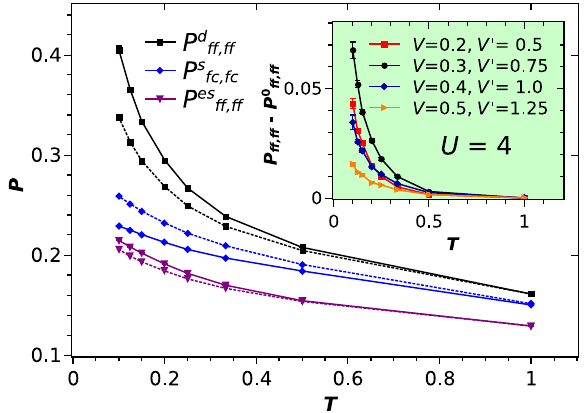
FIG. 1. Pairing susceptibilities for V ¼ 0 . 3 ; V 0 ¼ 0 . 75 ; U ¼ 4 calculated with DQMC on a 12 × 12 × 2 lattice with periodic boundary conditions. The Trotter decomposition imaginary time interval is Δ τ ¼ 0 . 0625 . Solid curves denote susceptibilities P including vertex contributions while dashed lines represent the bubble contribution P 0 . The inset shows the effective pairing interaction P − P 0 for d pairing in the ð ff; ff Þ channel, x 2 − y 2 keeping the ratio V 0 =V constant but changing the hybridization gradually from V ¼ 0 . 2 ; V 0 ¼ 0 . 5 to V ¼ 0 . 5 ; V 0 ¼ 1 . 25 . In- creasing the hybridization makes the f electrons more itinerant. Fig. 1, where DQMC results suggest that, at fixed V 0 =V , the